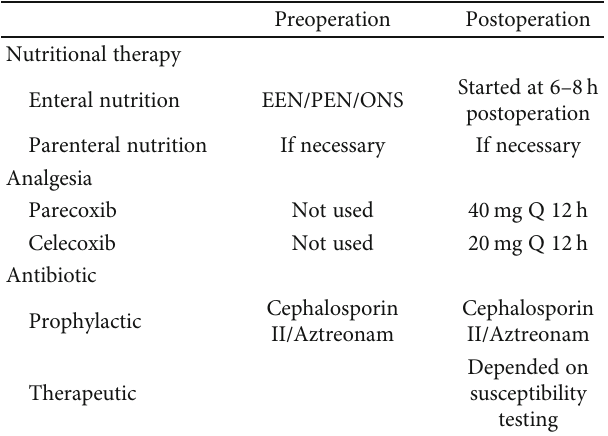
Table 5: Pre- and postoperative